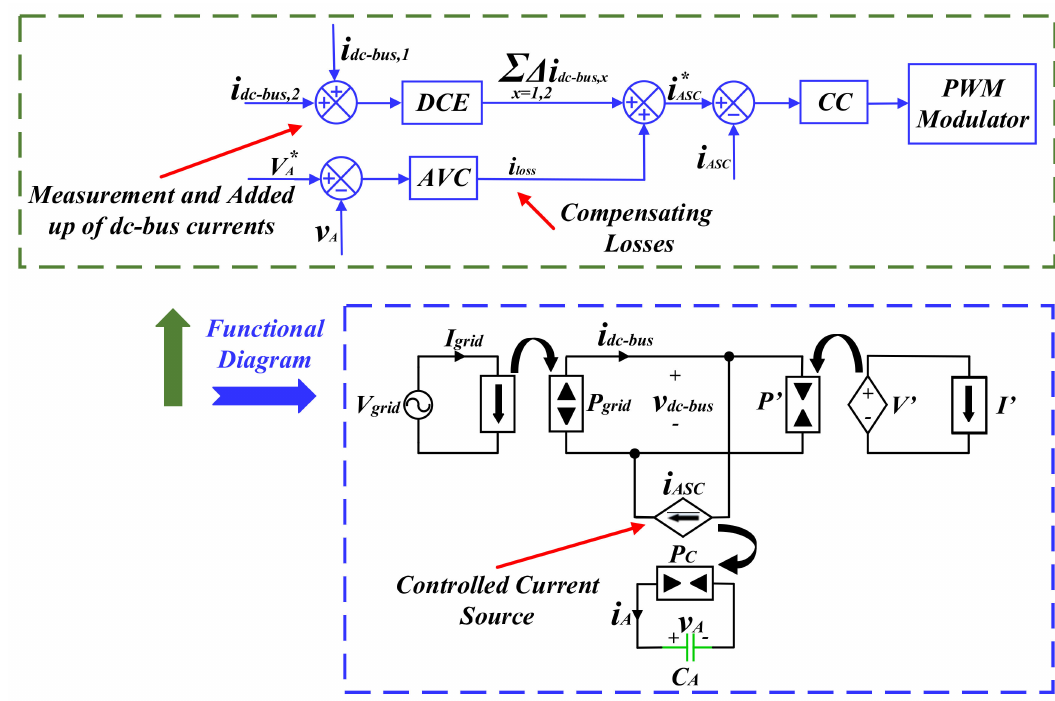
Figure 15. Controlled current source strategy, control structure, and functional